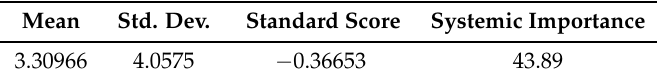
Table 2. Greece’s size.